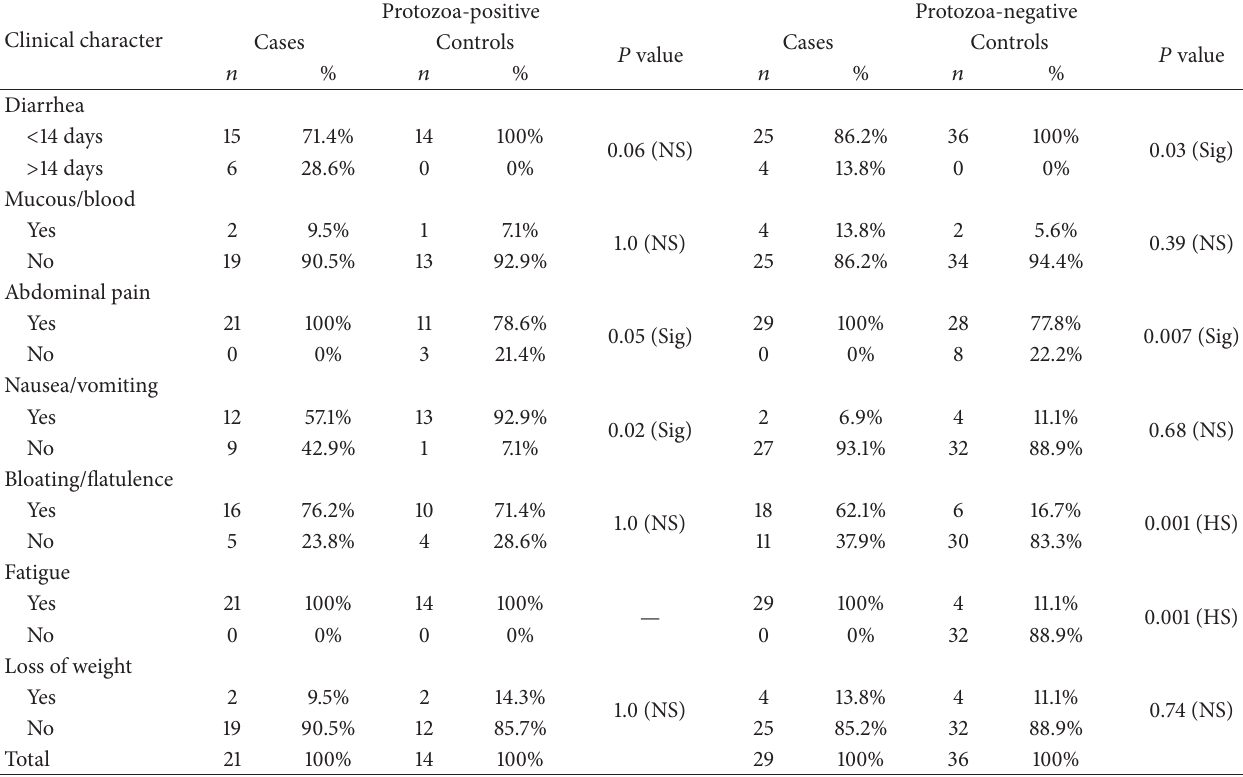
Table 2: The clinical characteristics variations among the parasitized and non-parasitized diarrheal cases and controls. Protozoa-positive Protozoa-negative Clinical character